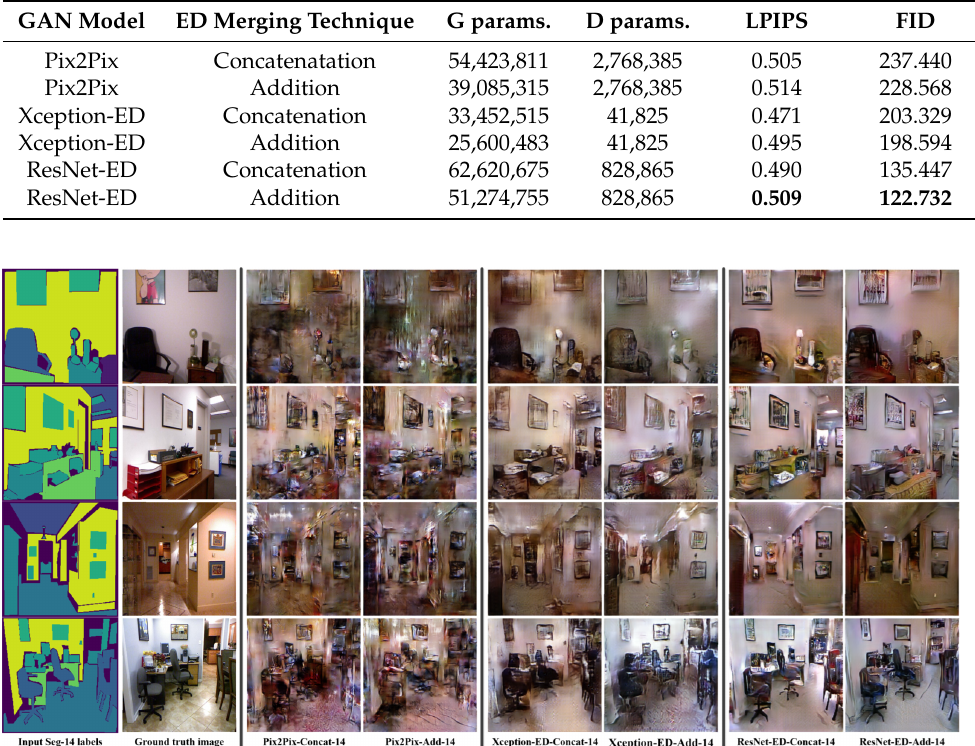
Figure 3. Sample results were obtained by Pix2Pix, Xception-ED, and ResNet-ED with concatenation and addition as feature merging of the encoder and decoder features while training with 14 semantic labels on the NYU depthV2 dataset.